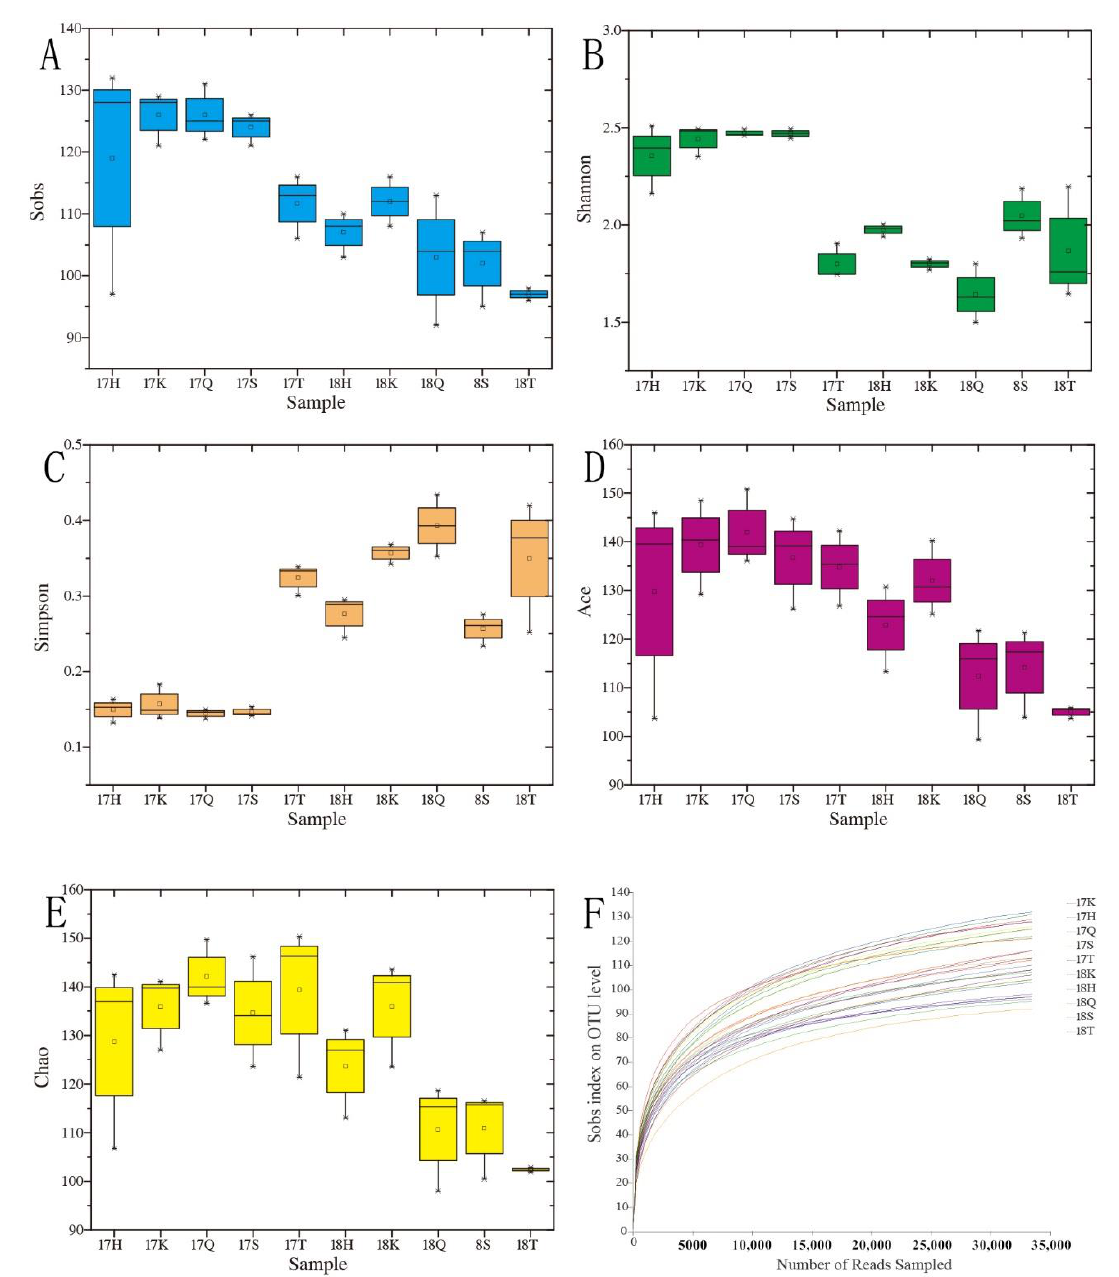
Figure 2. Alpha diversity assessment ( A – E ): Sobs ( A ) is the observed OTU number, the Shannon ( B ) and Simpson ( C ) indexes were used to represent community diversity, and the ACE ( D ) and Chao ( E ) indexes and rarefaction curves ( F ) were used to represent community taxa richness.